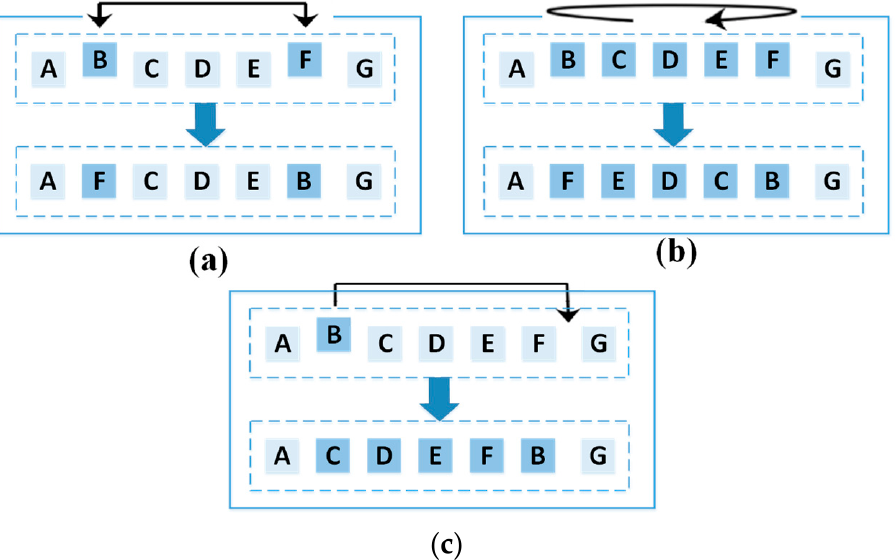
Figure 8. A schematic of the utilized mutation operators, ( a ) swap, ( b ) reversion, and ( c ) insertion.